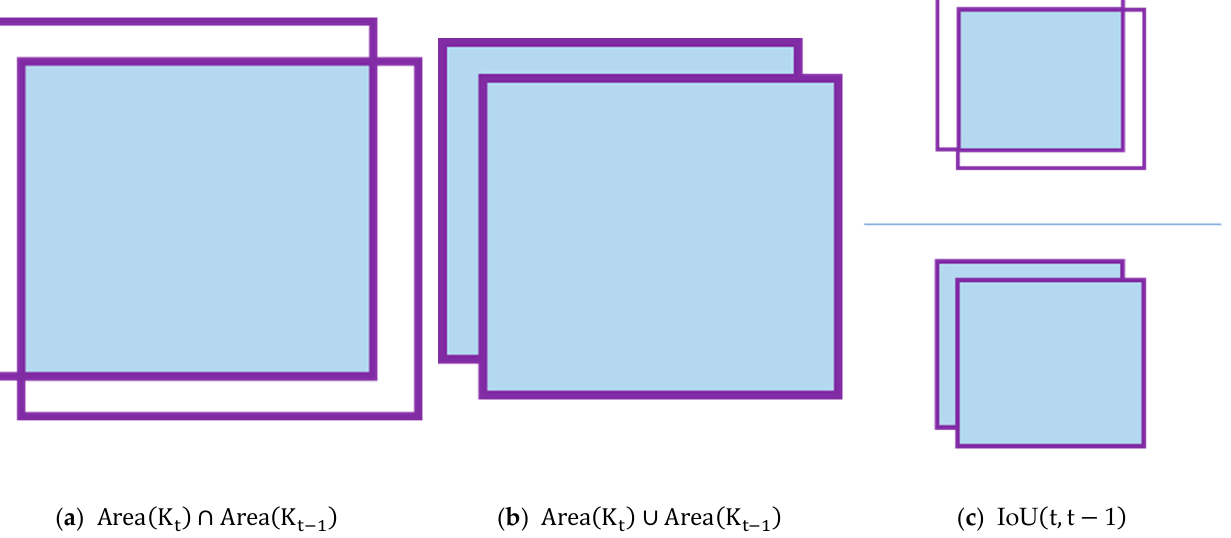
Figure 3. IoU of two areas. IoU is calculated by dividing the overlap between two areas by the union of these.